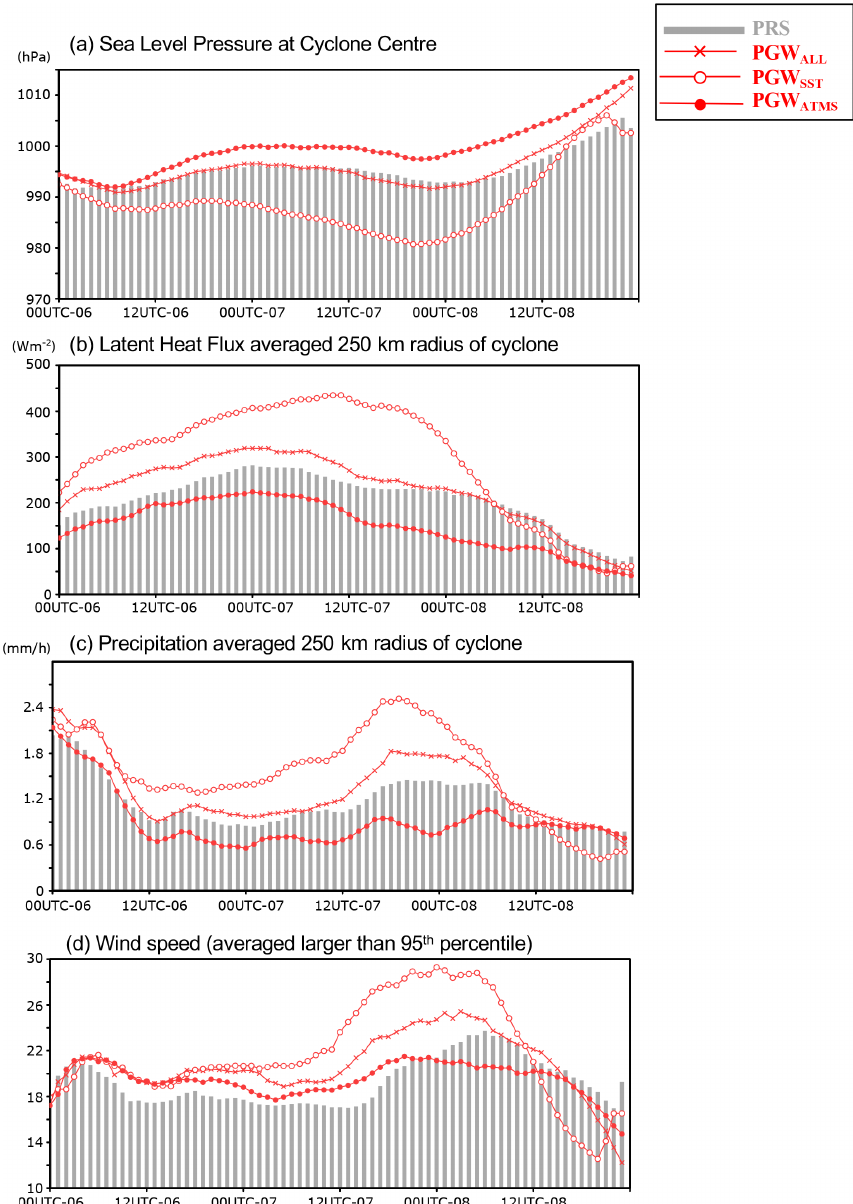
Figure 6. Time series of ensemble of (a) SLP at grid of cyclone centre, (b) latent heat flux, (c) precipitation averaged, and (d) averaged wind speed exceeding the 95th percentile within the 250km radius of the simulated medicane. Panels (b) and (c) are averaged values within a 250km radius. The grey bar and red lines denote the variables of PRS and PGWs (with different markers), respectively. All variables are the ensemble mean. Note that the values of TD_TP_MN and TD_W5_MN in PGWSST are excluded from the ensemble mean from 20:00–08:00 and 21:00–08:00UTC, respectively, due to the extinction of simulated